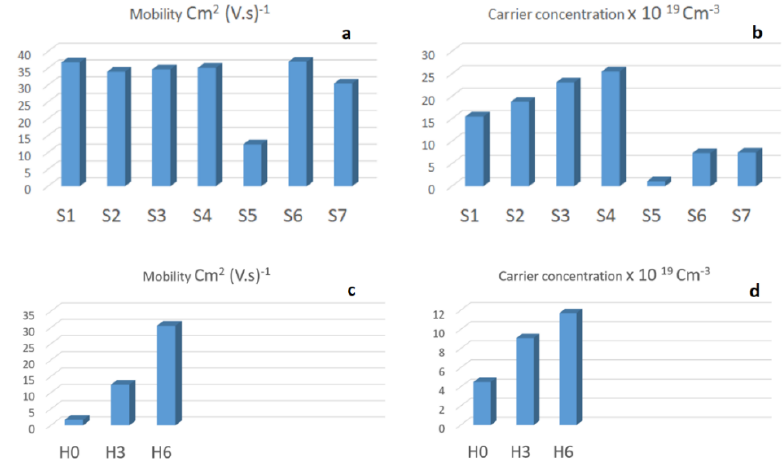
Figure 7. ( a ) Apart from the sample S5, the mobility of the charge carriers does not seem to be affected significantly. ( b ) The carrier concentration seems to be improving with each consecutive deposition under Ar + H gas. The value drops significantly during the transition period where the S5 sample was deposited. The samples S6 and S7, which were coated under Ar gas, show a significantly lower value of carrier concentration compared to the samples coated under Ar + H gas. ( c , d ) In ZnO samples prolonged exposure to the Ar + H gas significantly enhances the mobility and carrier concentration values.